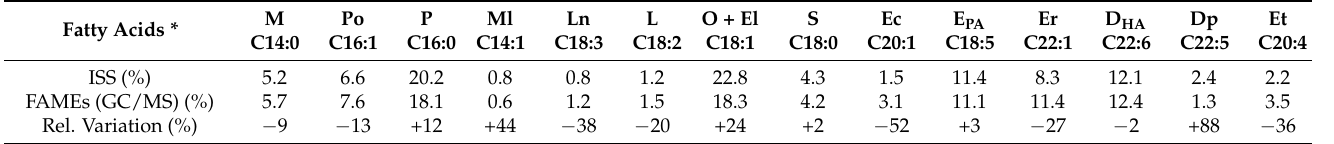
Table 1. Fatty acid composition of tuna fish oil determined by independent approaches.